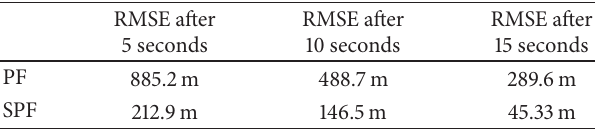
Figure 15: Tracking performance for multiple targets (20MC trials). Table 3: RMSE comparison (20 MC